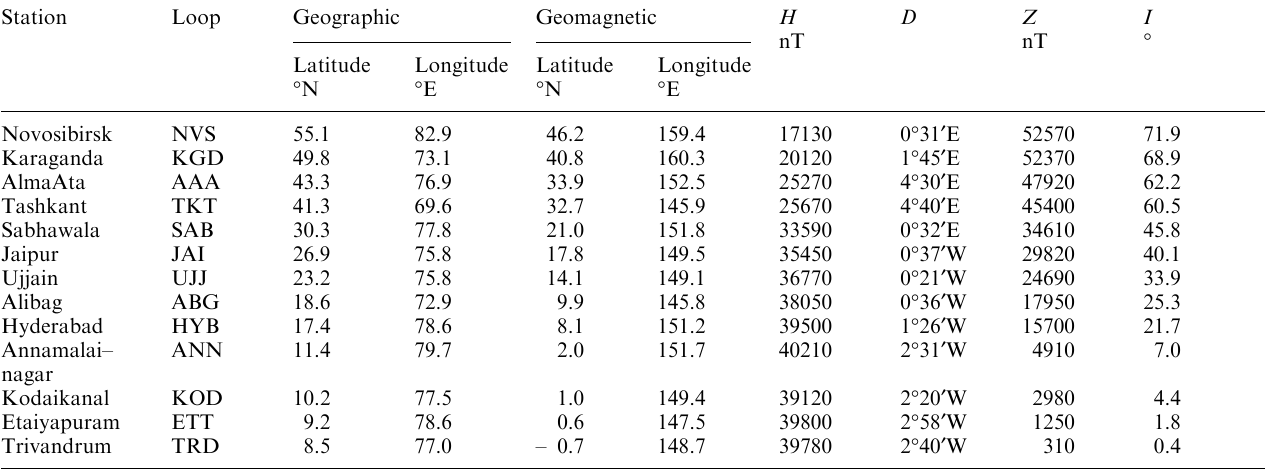
Table 1. List of the geomagnetic observatories in the Indo-USSR chain together with geomagnetic field parameters during January– February, 1987 Station Loop Geographic